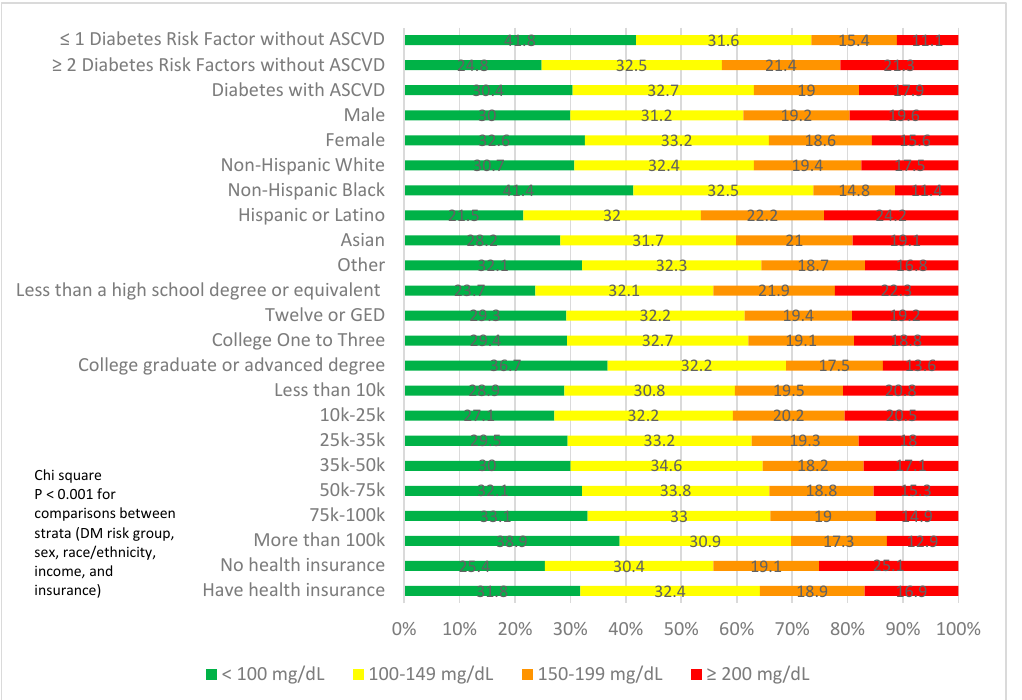
Figure 2. Proportion of subjects at ideal, borderline, or poor triglyceride control by ASCVD risk group, sex, ethnicity, education, income, and health insurance. p < 0.001 across risk, sex, ethnicity, education, income, and health insurance status categories. Table 3. Prevalence of high-intensity statin, ezetimibe, PCSK9 inhibitor, and icosapent ethyl treat- ments in Adults with DM across health insurance, education, and